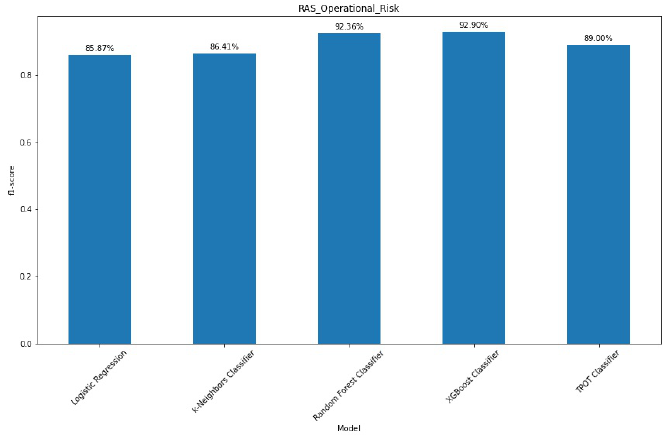
Figure 8. F1-scores of each model, using cross-validation